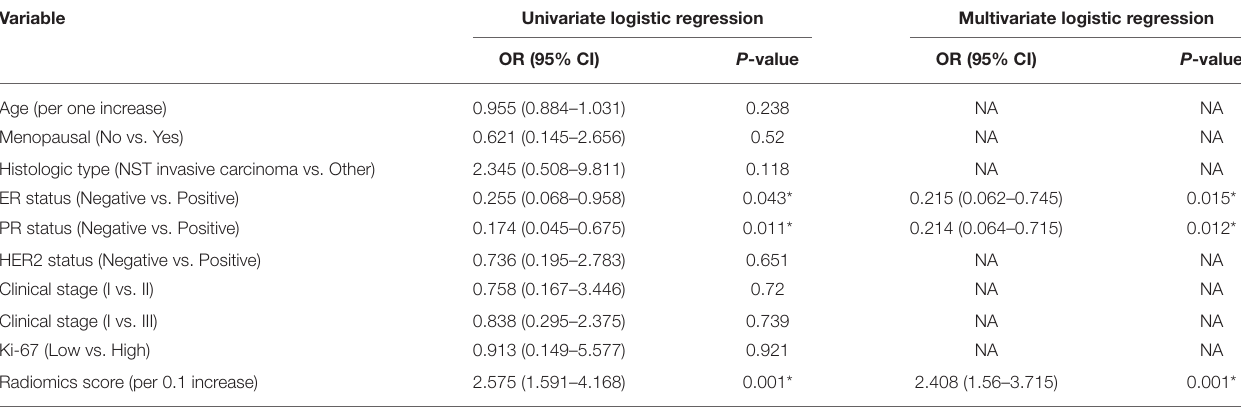
TABLE 3 | Logistic regression analysis for predicting pCR in breast cancer (BCa) patients.